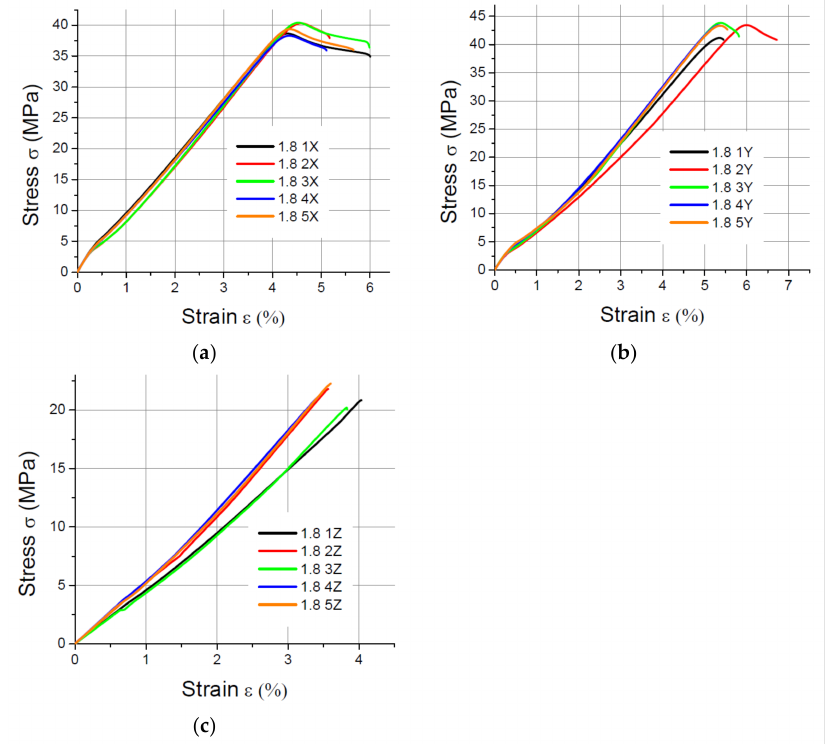
Figure 6. Tensile test results for 1.8 mm thick specimens made of PLA printed in ( a ) the X orientation; ( b ) the Y orientation; ( c ) the Z orientation.